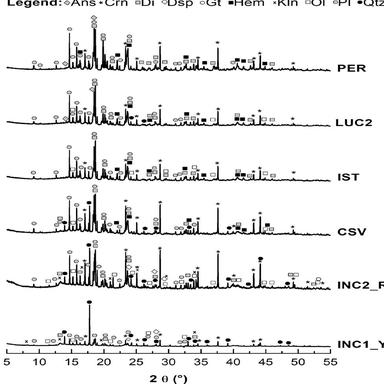
XRD pattern of Ghiara samples. Sample labels: PER = Perniciano; LUC2 = Lucenti; IST = Istrice; CSV = Contrada S.Vito; INC1_Y and INC2_R = Incaria; b) mineralogical phases: Crn = corundum; Di = diopside; Ans = Anorthoclase; Dsp = diaspore; Gt = goethite; Hem = hematite; Kln = kaolinite; Ol = olivine; Pl: plagioclase; Qtz: quartz.